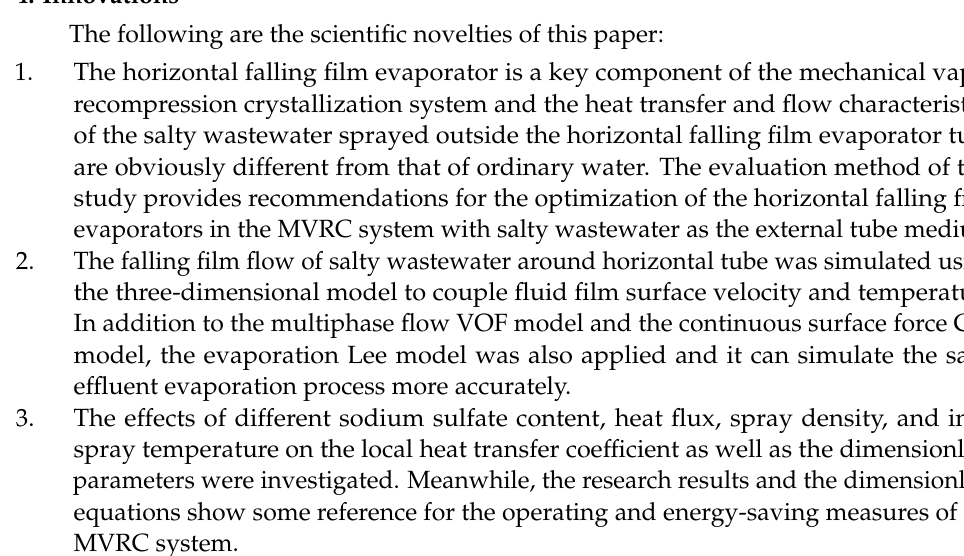
Figure 12. Error comparison diagram of the fitted and experimental data [24].